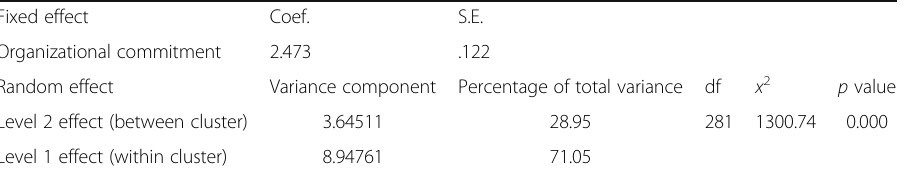
Table 3 Organizational commitment: results of the null model Fixed